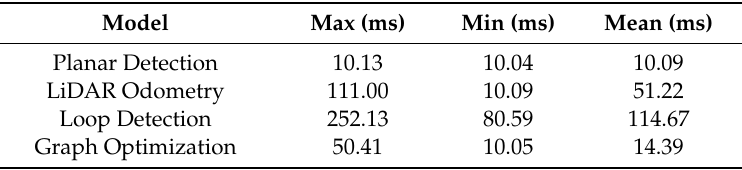
Table 2. GICP-SLAM module runtime.